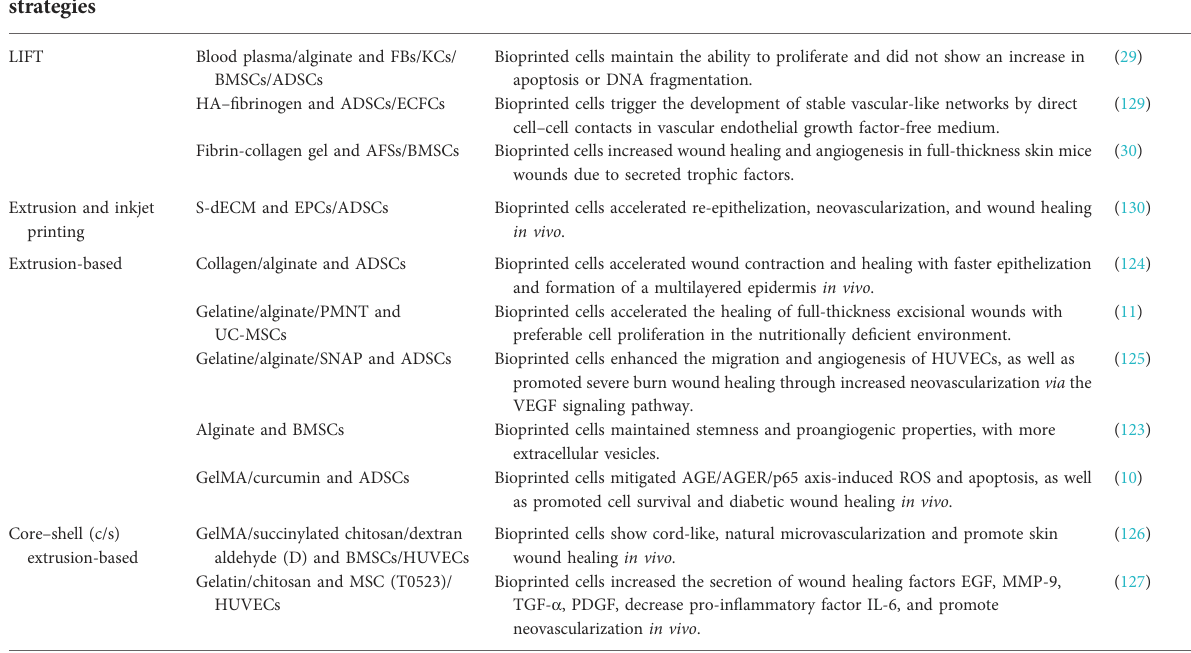
TABLE 1 Research about 3D-bioprinted MSCs in skin tissue